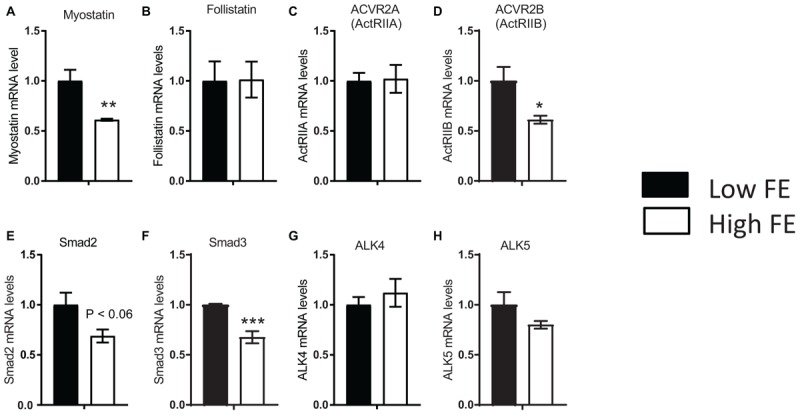
Differentially expressed genes that are involved in myostatin signaling in breast muscle from Pedigree Male (PedM) broilers exhibiting high or low feed efficiency (FE) phenotype. Relative expression of mRNA is shown for myostatin (A), follistatin (B), activin receptor types IIA and IIB (ActIIA and Act IIB) (C,D), Mothers against decapentaplegic homolog 2 and 3 (Smad2 and Smad3) (E,F), and activin receptor-like kinase 4 and 5 (ALK 4 and ALK 5) (G,H). Bars represent the mean + SE (n = 5). Mean values were different at ∗P ≤ 0.05, ∗∗P ≤ 0.01, or ∗∗∗
P ≤ 0.001.